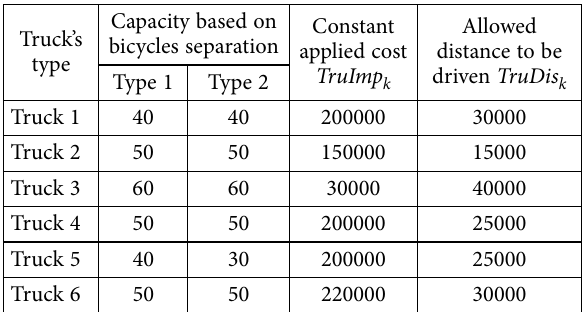
Table 3. Data related to the trucks for both numerical examples